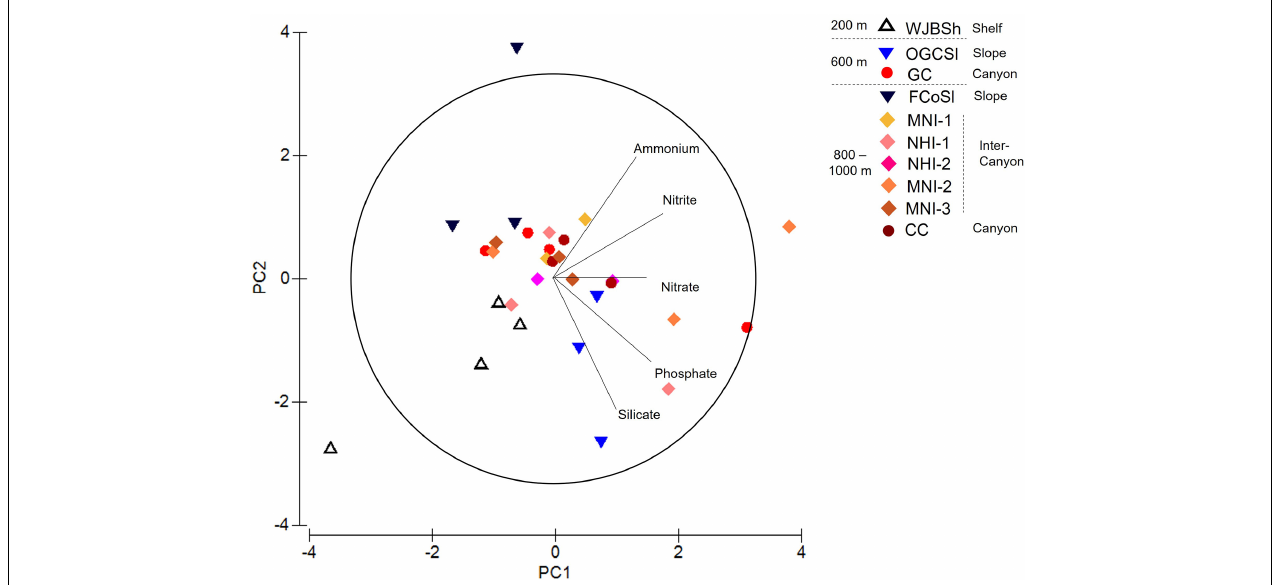
FIGURE 3 | Principal Component Analysis (PCA) of all the inorganic nutrient fluxes at the sediment-water interface. Vectors show the strength and direction of each nutrient flux to the overall variation of benthic nutrient fluxes.